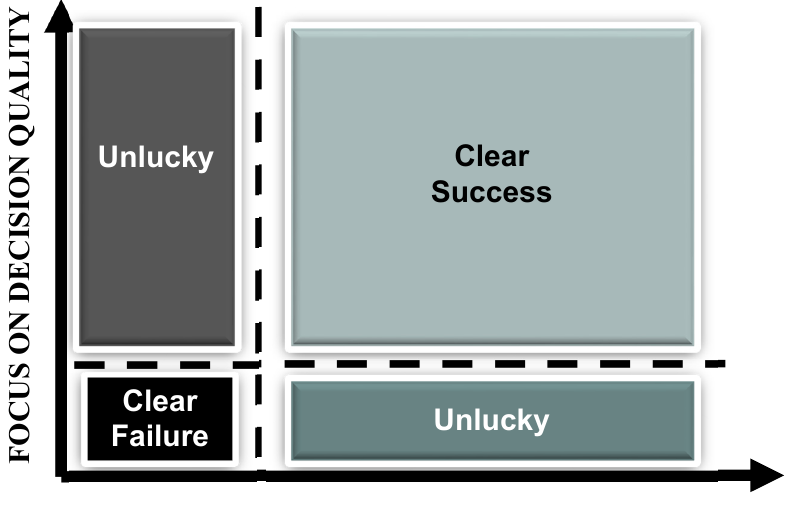
Figure 2. Due to existing uncertainties in deciding on a choice, a high-quality decision can still result in poor outcome and vice versa.